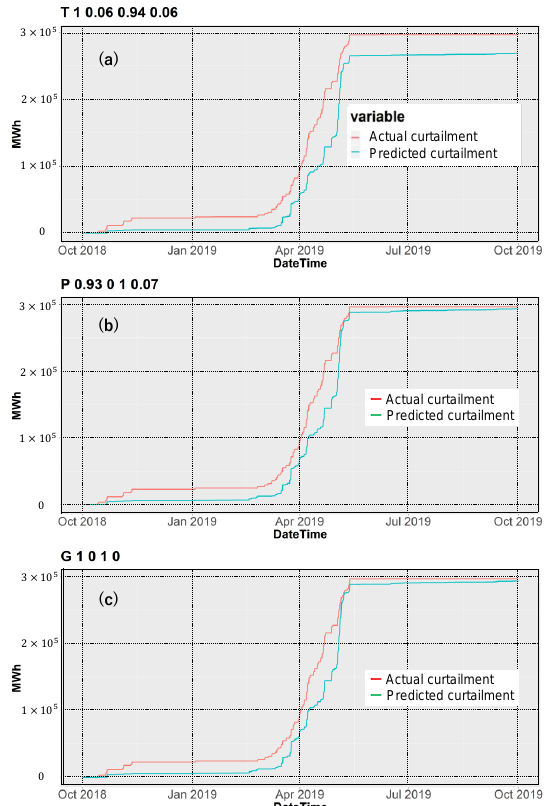
Figure 10. ( a ) Validation results with four calibrated parameters of (1, 0.06, 0.94, 0.06) for thermal (T); ( b ) validation results with four calibrated parameters of (0.93, 0, 1, 0.07) for pumped storage (P); and ( c ) validation results with four calibrated parameters of (1, 0, 1, 0) for grid interconnection (G). The red lines indicate the actual cumulative curtailments and the blue lines represent the predicted curtailments.